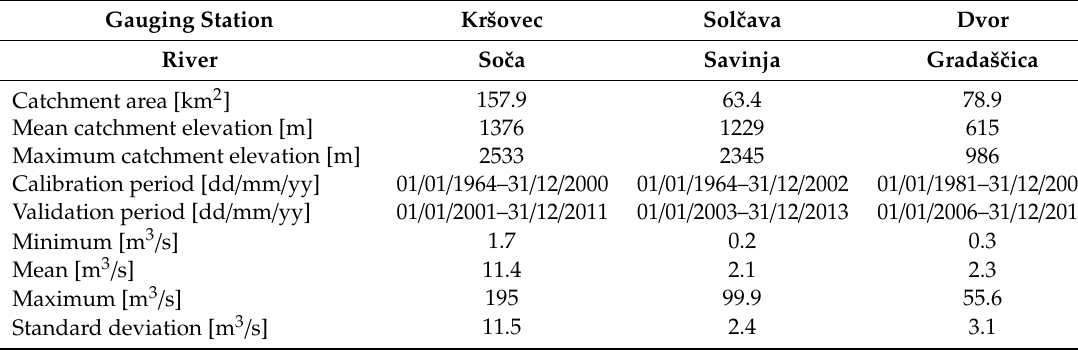
Figure 1. Location of the selected catchments (red border), meteorological stations (yellow crosses), discharge gauging stations (pink arrows) on the topographic map of Slovenia. Table 1. Basic characteristics of the selected case studies and discharge data used.